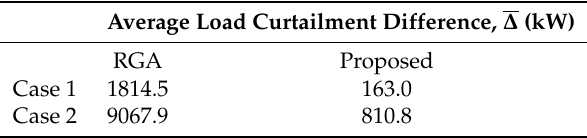
Table 3. Comparison of the average load difference produced by all compared methods.